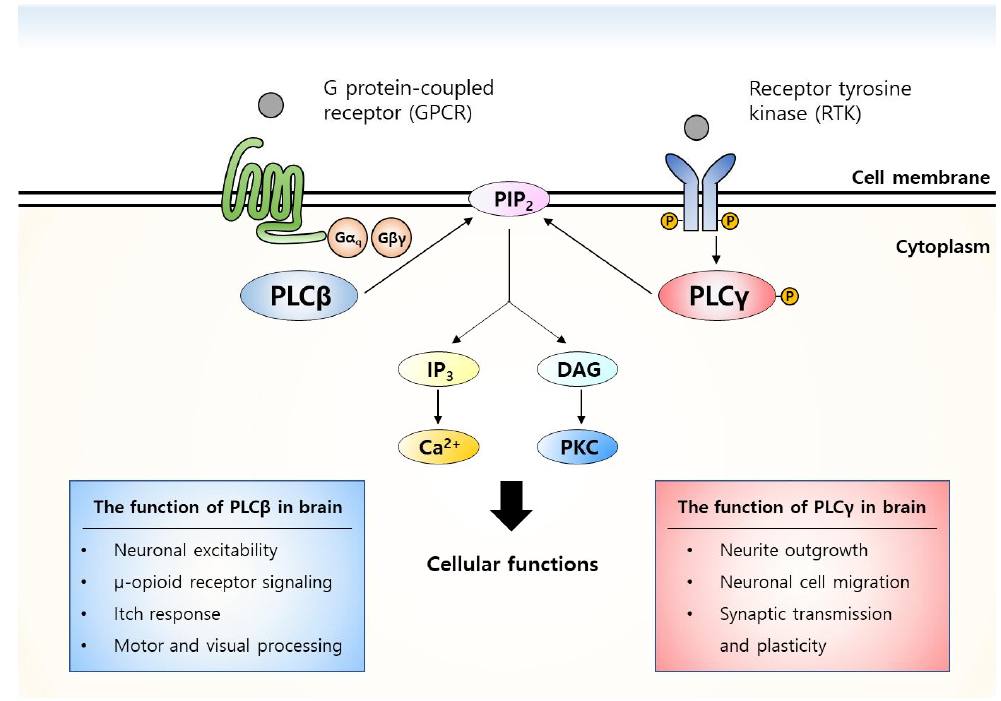
Figure 1. The principal PLC signaling cascades and functions in the brain. External ligands such as neurotransmitters and neurotrophic factors bind to and activate the upstream transmembrane receptors of PLC. PLCβ is activated by Gα q and Gβγ subunits of G protein-coupled receptors (GPCRs), whereas the activation of PLCγ is triggered by the phosphorylation of receptor tyrosine kinases (RTKs). Activation of PLC hydrolyzes phospholipid PIP 2 into IP 3 and DAG and these second messengers mediate diverse neuronal functions.